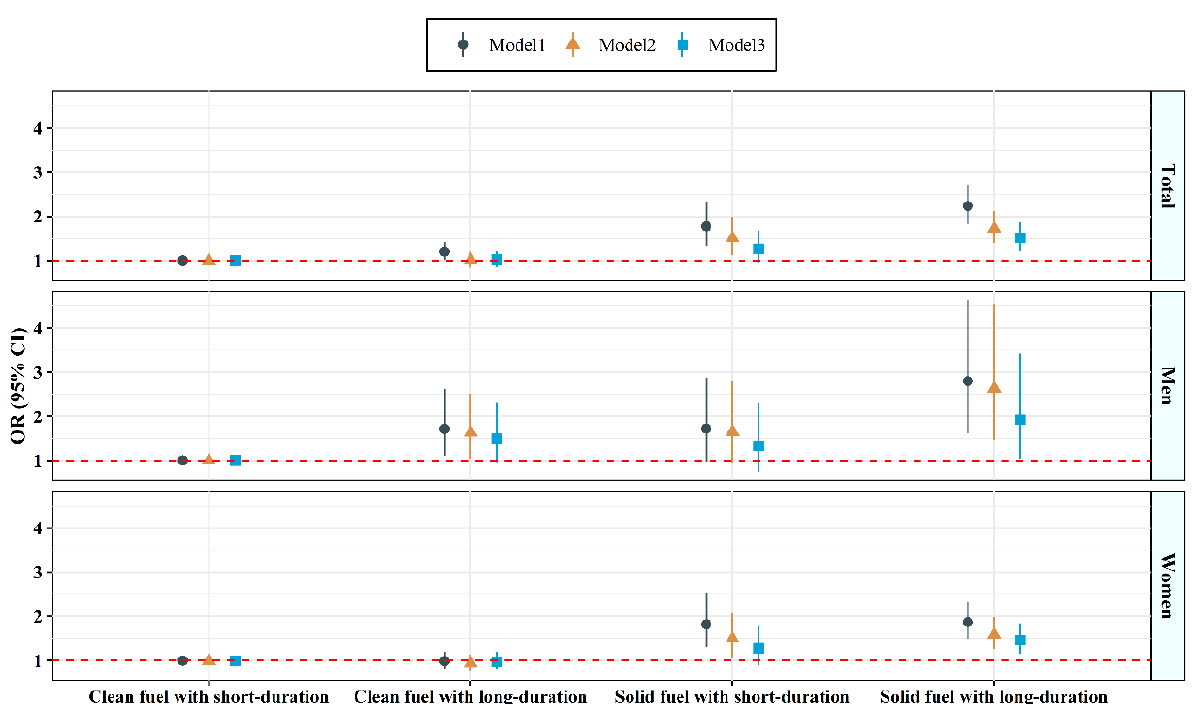
Figure 1. Combined associations of fuel type and cooking duration with suicidal ideation. Model 1 was unadjusted; Model 2 adjusted for age and region in men and women, and additionally adjusted for gender in total; Model 3 further adjusted for marital status, educational level, average monthly income, smoking status, drinking status, high fat diet, fruit and vegetable intake, physical activity, BMI, hypertension, T2DM, CHD, and stroke, ventilation based on model 2.